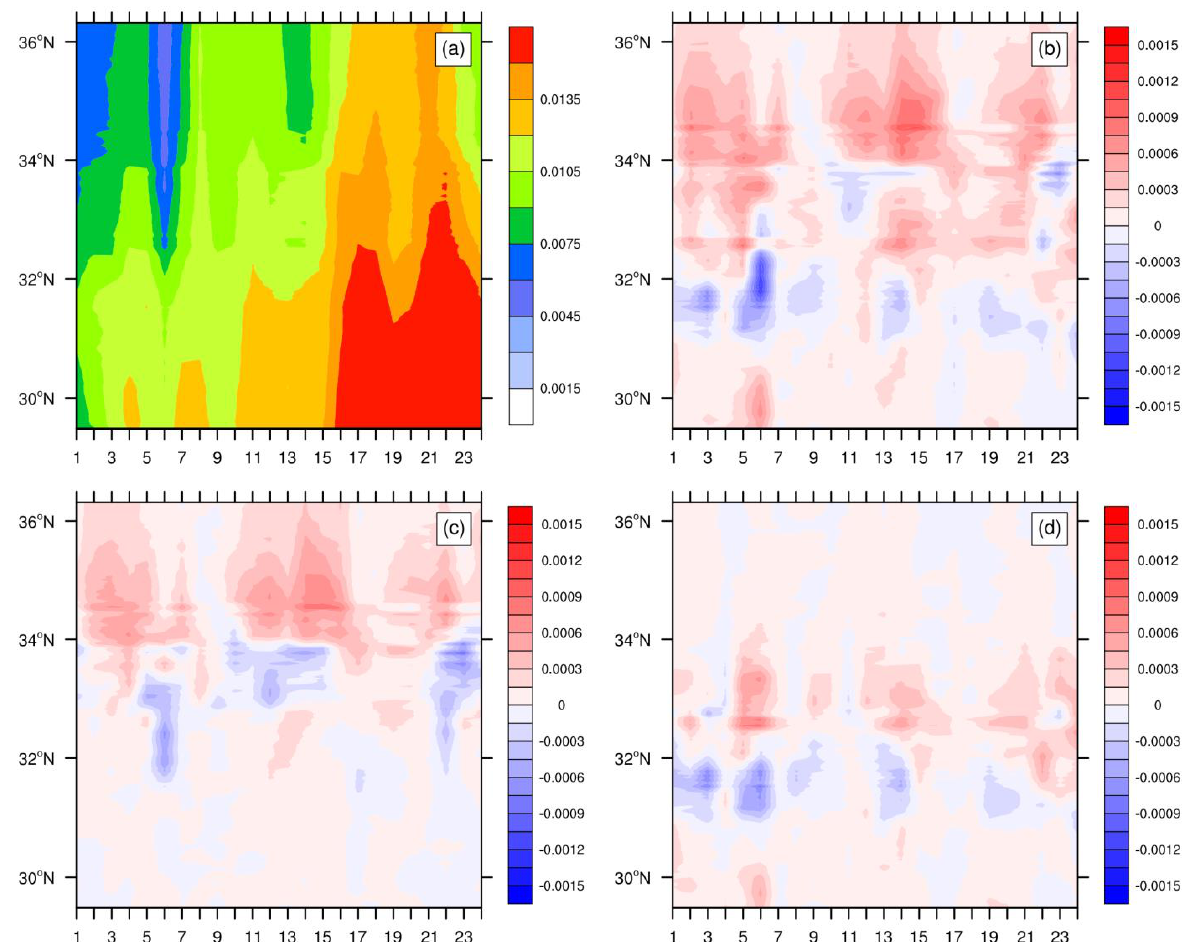
Figure 9. Diurnal-latitude diagrams, where diurnal-latitude diagrams of water vapor mixing ratio (kg kg −1 ) at 850 hPa averaged in domain 3 in CTRL ( a ). Panels ( b – d ) are the differences ( b ) between LowQD and CTRL (LowQD minus CTRL), ( c ) between LowQ and CTRL (LowQ minus CTRL), as well as ( d ) between LowD and CTRL (LowD minus CTRL), respectively. Blue (red) shading indicates negative (positive) variation.